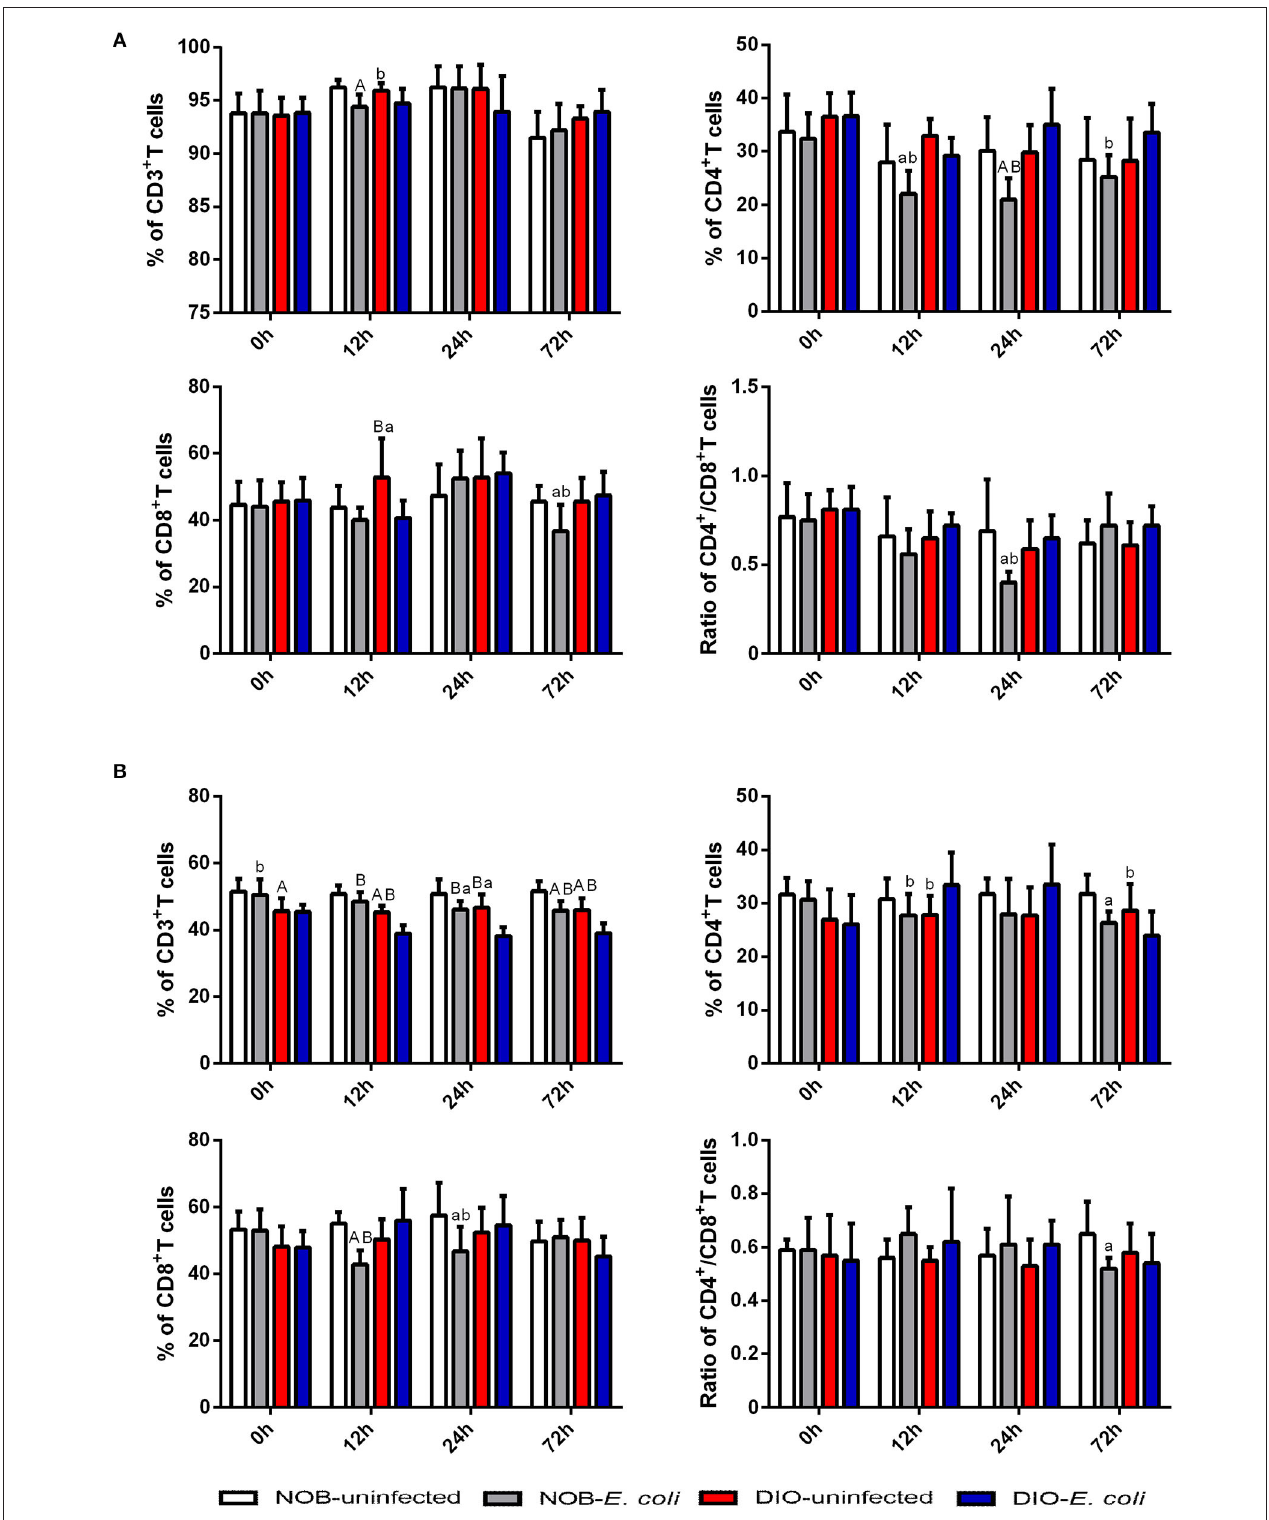
FIGURE 1 | The alterations of intestinal CD3 + T cells, CD4 + T cells, CD8 + T cells, and CD4 + /CD8 + T cells in 0, 12, 24, and 72h post-infection. Intestines were collected aseptically for lymphocyte isolation from mice of each group in 0, 12, 24, and 72h post-infection. (A) The percentage of CD3 + T cells, CD4 + T cells, CD8 + T cells, and CD4 + /CD8 + T cells in the intestinal epithelium (IELs). (B) The percentage of CD3 + T cells, CD4 + T cells, CD8 + T cells, and CD4 + /CD8 + T cells in intestinal lamina propria (LPLs). The data from each group are presented as the mean ± SD ( n = 8). a, p < 0.05 compared with group NOB-uninfected; A, p < 0.01 compared with group NOB-uninfected; b, p < 0.05 compared with group DIO- E. coli ; B, p < 0.01 compared with group DIO- E. coli .